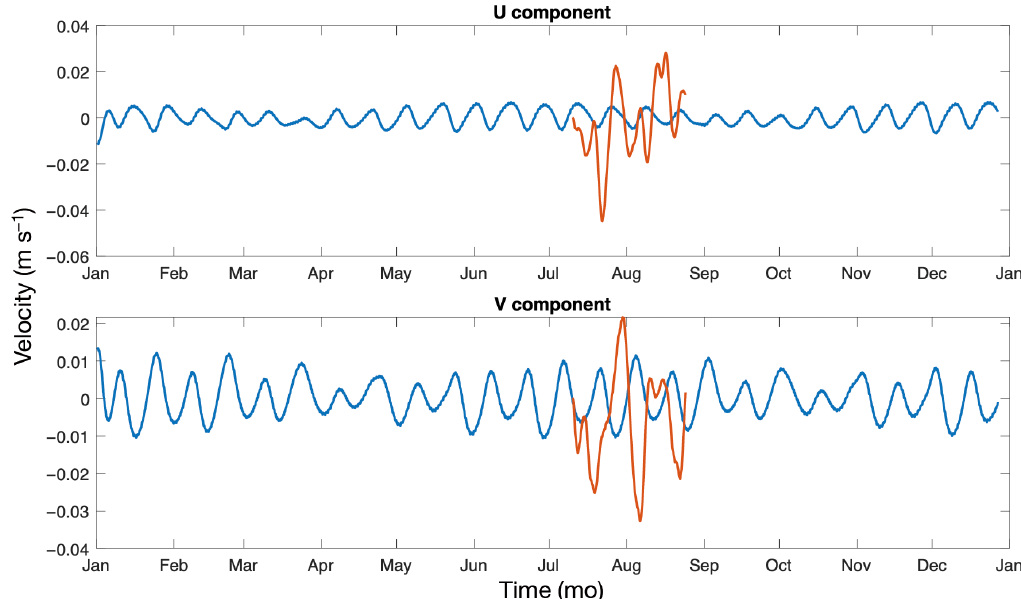
Fig. 7. Time series of 7 d low-passed current component close to the bottom at Site P1 from the model results of the tides only simulation of 2017. Red line: similar current component from observations, including additional forcing compared to the